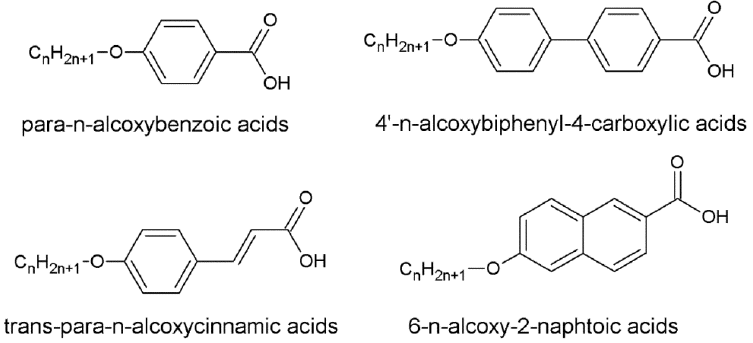
Figure 3. Molecular structures of different liquid crystal families with carboxylic acid as functional group.